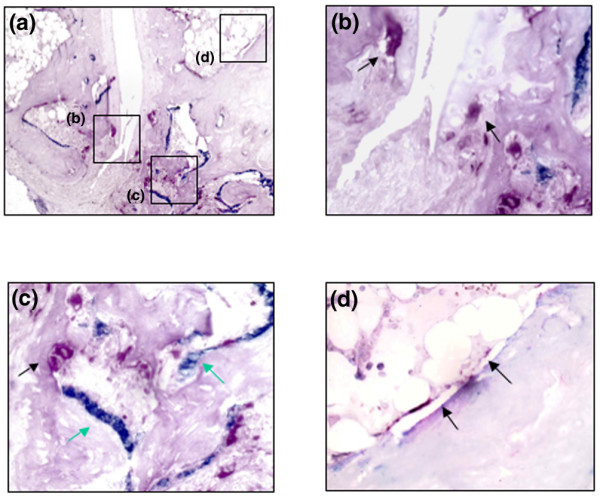
Double labeling for osteocalcin and tartrate-resistant acidic phosphatase for visualization of osteoblasts and osteoclasts. Paraffin-embedded sections of hind paws from arthritic mice transgenic for human tumor necrosis factor (hTNFtg) were stained by TRAP to determine osteoclasts (black arrows; purple-colored cells with three or more nuclei). In the same sections, osteoblasts were visualized by in-situ hybridization for osteocalcin (green arrows; deep blue-stained cells). (a) Overview of a representative section, original magnification × 100. (b) Close-up view of the compartment of subchondral bone erosion, original magnification × 400. (c) Cortical bone channels underneath subchondral bone erosions, original magnification × 400. (d) Inflamed endosteal bone surface distant from bone erosion, original magnification × 400.